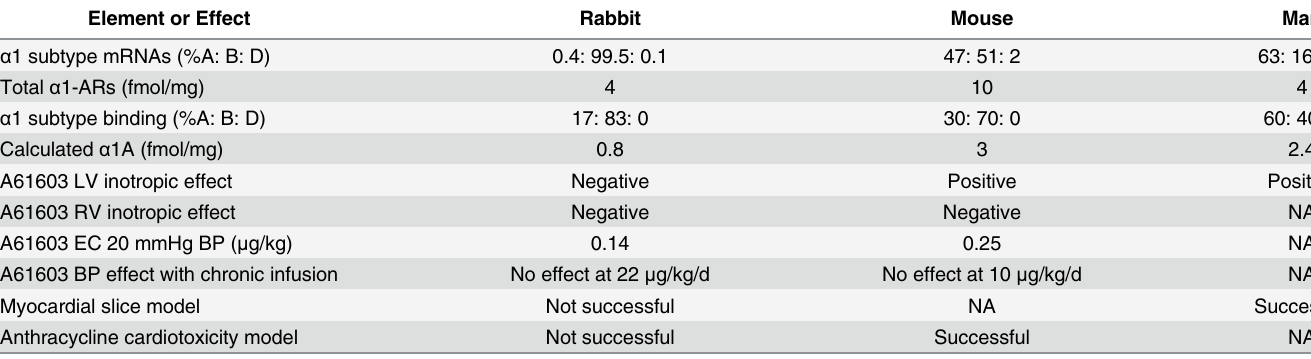
Table 1. α 1A-Adrenergic receptor subtype and effects in myocardium of rabbit, mouse, and man. Element or Effect Rabbit